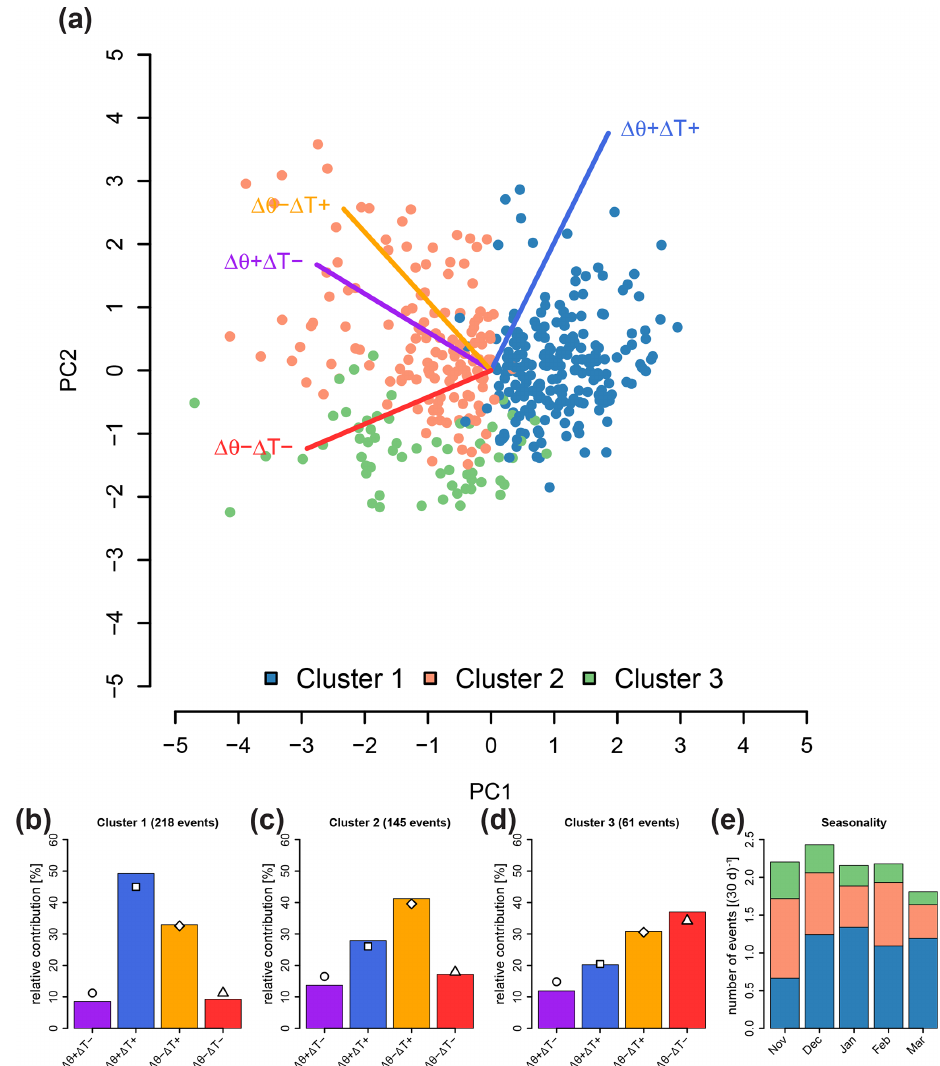
Figure 9. (a) Biplot for moist-air intrusions in the North Atlantic based on a PCA of the contributions of the four trajectory categories to the moisture transport. The projections of individual intrusions on PC1 and PC2 are shown by dots colored according to the intrusion’s attribution to clusters 1–3. Coloured lines indicate the projections of the original basis vectors (i.e., contributions to moisture transport) onto PC1 and PC2. Note that the latter have been scaled to optimize visibility, but relative magnitudes are retained. (b–d) Relative contributions of the four trajectory categories to the moisture transport (as in Fig. 6) for intrusions in (b) cluster 1, (c) cluster 2, and (d) cluster 3. (e) Mean number of intrusions per 30d (cluster 1: blue; cluster 2: red; cluster 3: